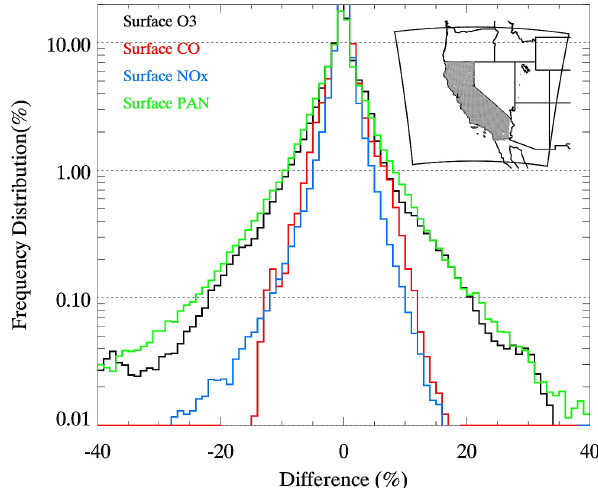
Fig. 12. Histograms in the percentage difference between surface concentrations of O 3 , CO, NO x and PAN over California between the WRF-Chem simulations with temporally varying and with tem- porally averaged chemical boundary